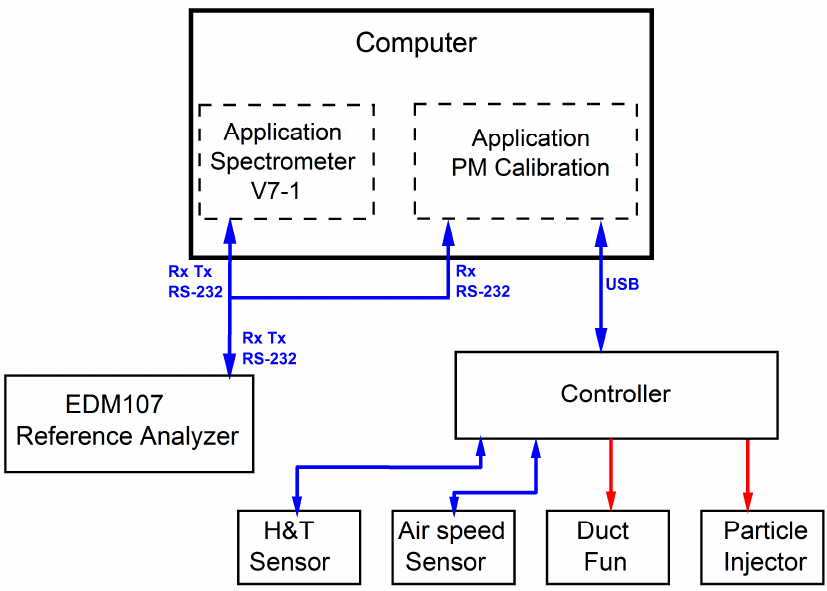
Figure 4. Schematic diagram of information flow in the calibration system. The continuous lines of the rectangle illustrate the hardware and the dashed lines of the rectangle represent software applications on the computer.